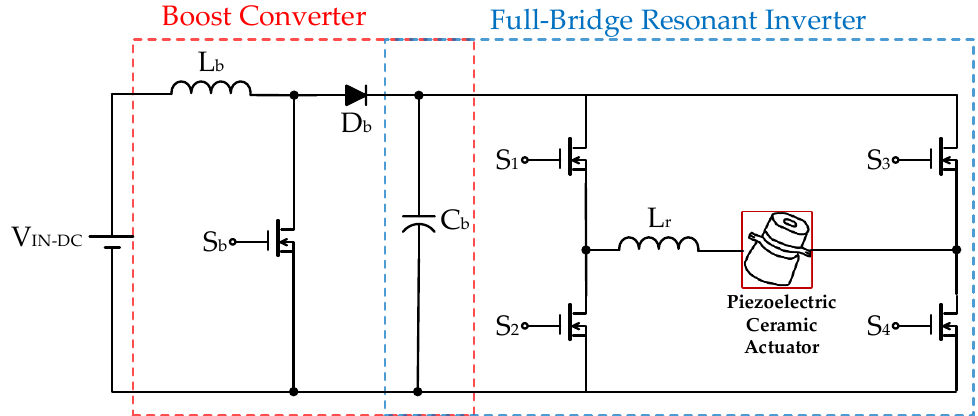
Figure 3. The conventional two-stage drive circuit for supplying a piezoelectric ceramic actuator applied with a DC input voltage source [12].